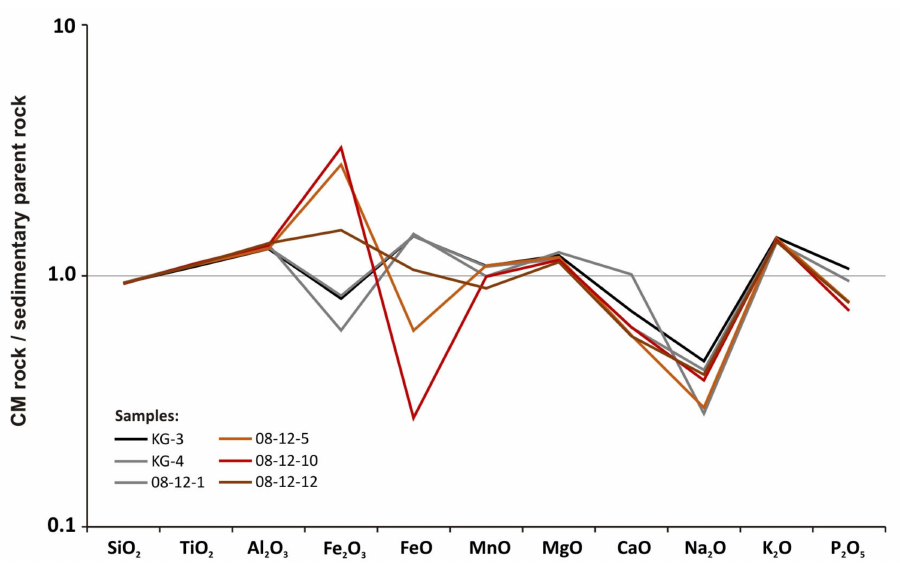
Figure 4. Major-element patterns for the Karabetova Gora CM rocks normalized to protolith compo- sition (mud composed of Middle Maykop shale), based on data from Table